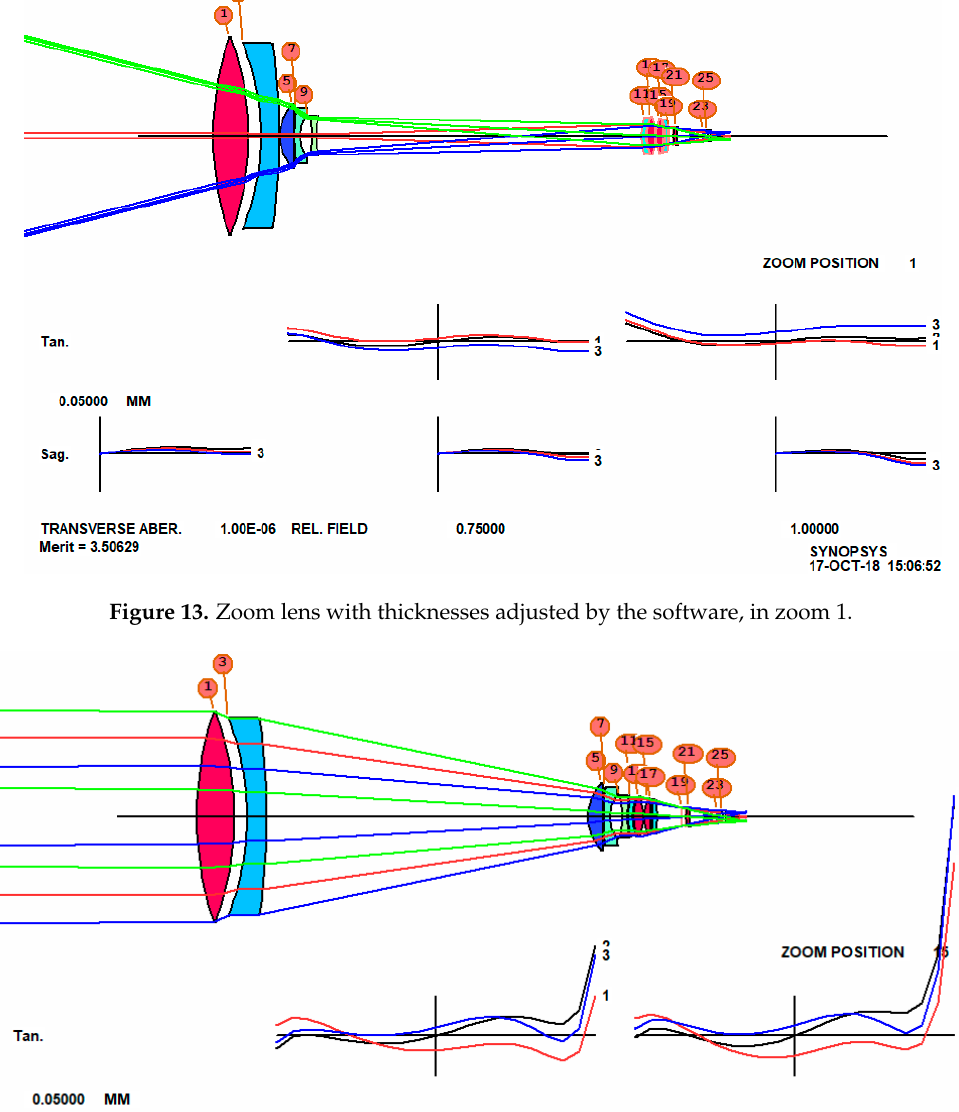
Figure 12. Zoom lens with element added by automatic element insertion (AEI).